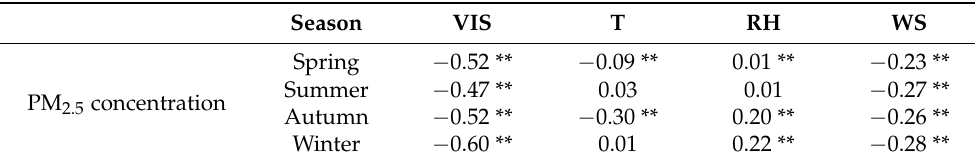
Table 1. Correlation coefficient between PM 2.5 mass concentration and meteorological factors in Yancheng from 2017 to